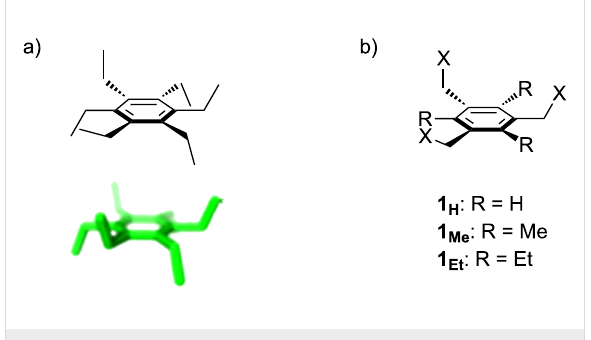
Figure 1: a) The global minimum-energy conformation for hexaethyl- benzene reveals the basis for steric gearing in crowded arenes. b) A generalized set of hosts based on 1,3,5-triethylbenzene ( 1 Et ) , 1,3,5- trimethylbenzene ( 1 Me ) , and an unsubstituted analogue ( 1 H ) .